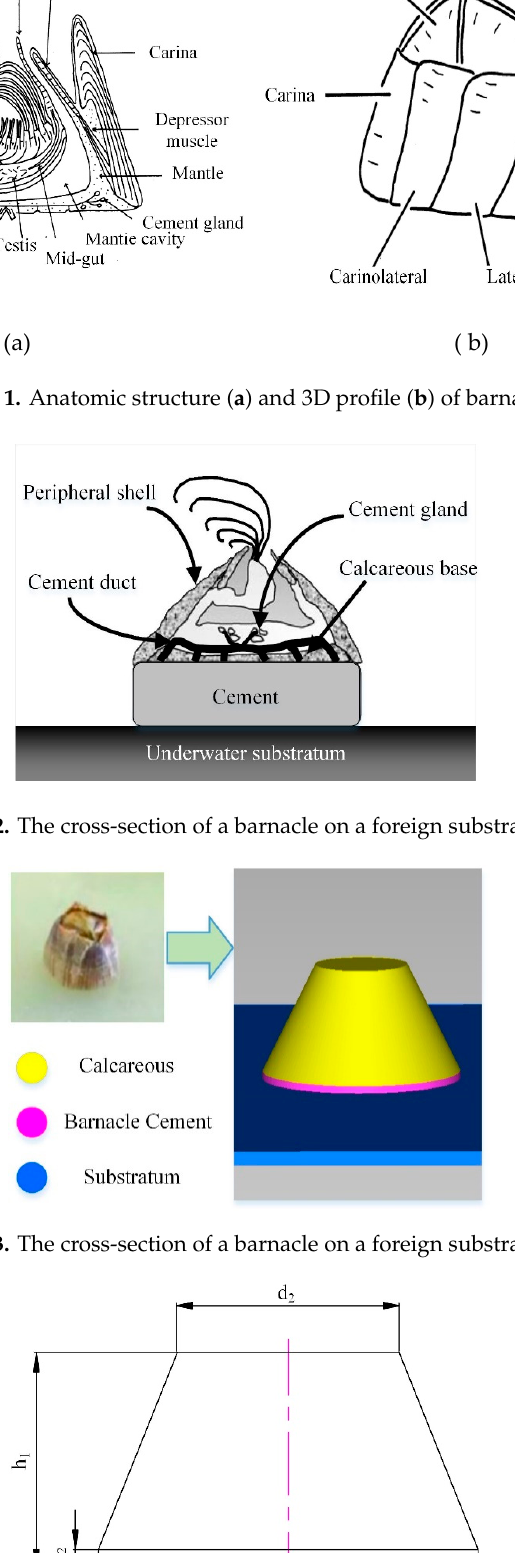
Figure 1. Anatomic structure ( a ) and 3D profile ( b ) of barnacle.